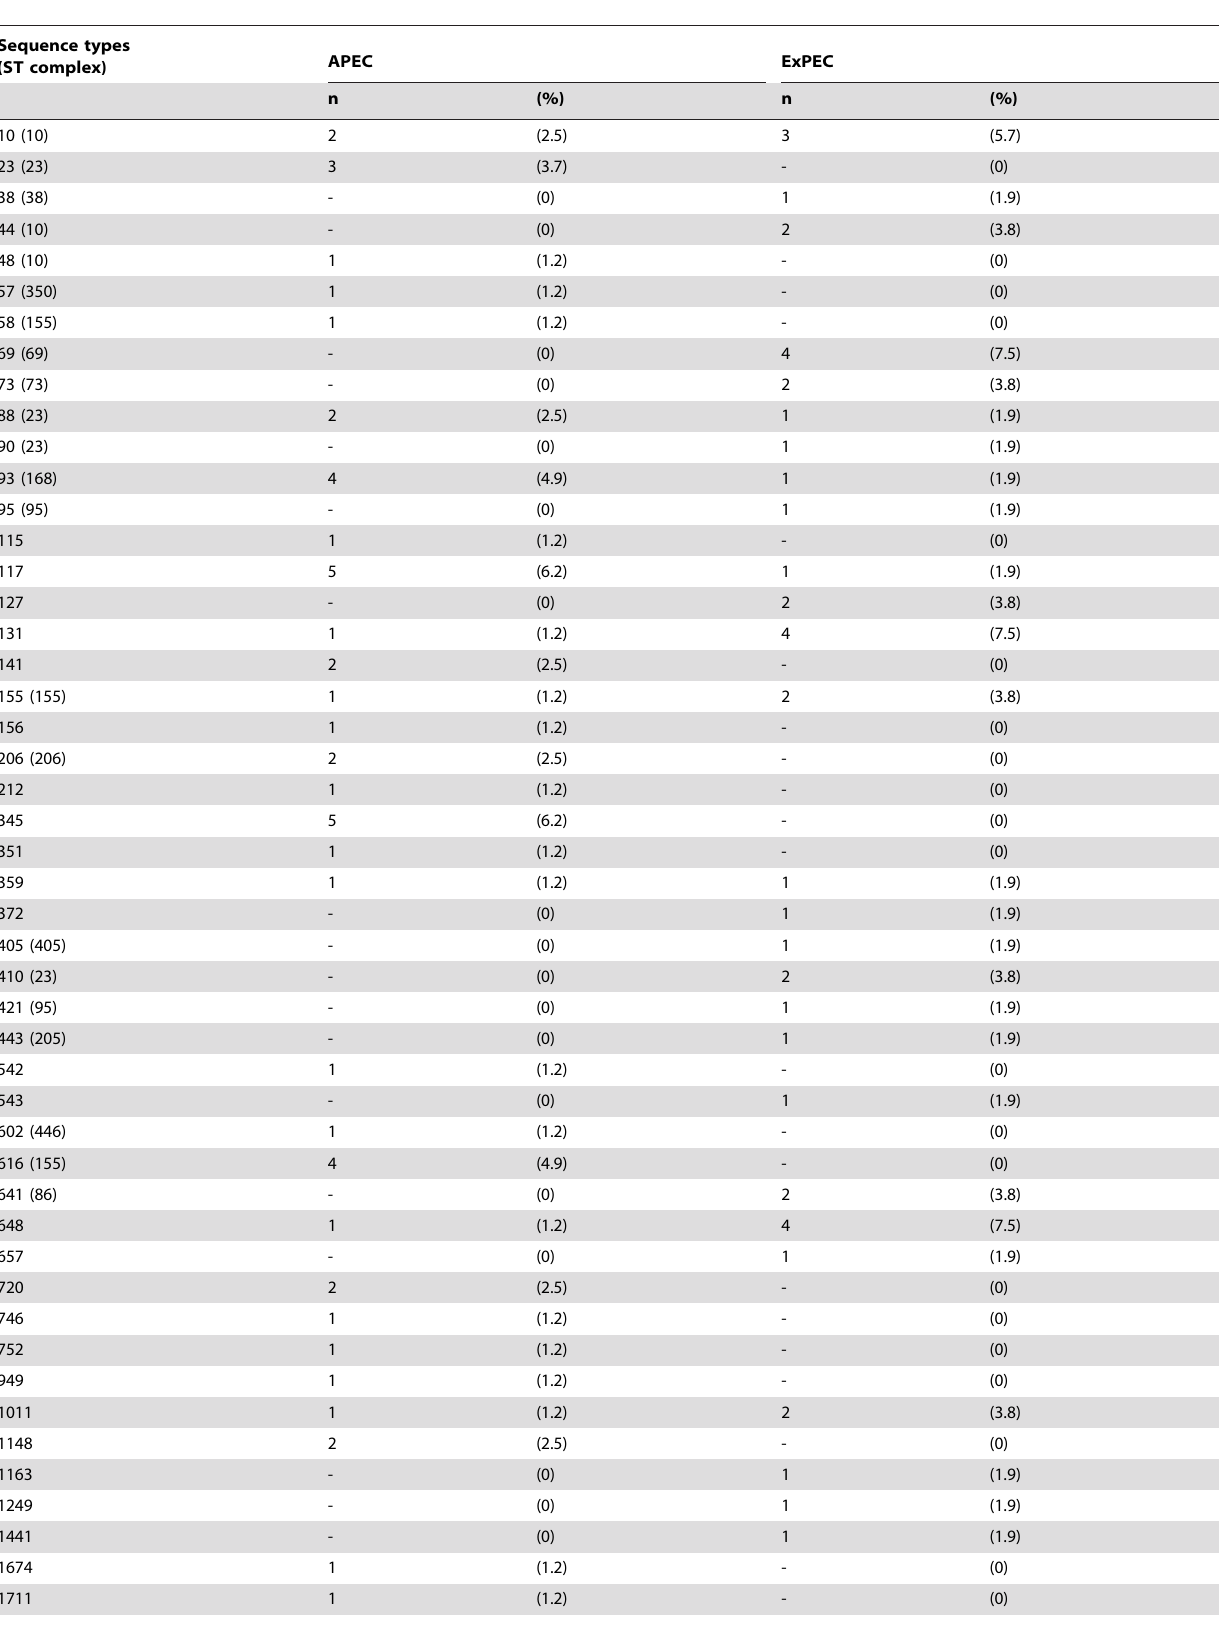
Table 3. Frequencies of sequence types (STs) among APEC (n=76) and ExPEC (n=53) strains isolated in Brazil.